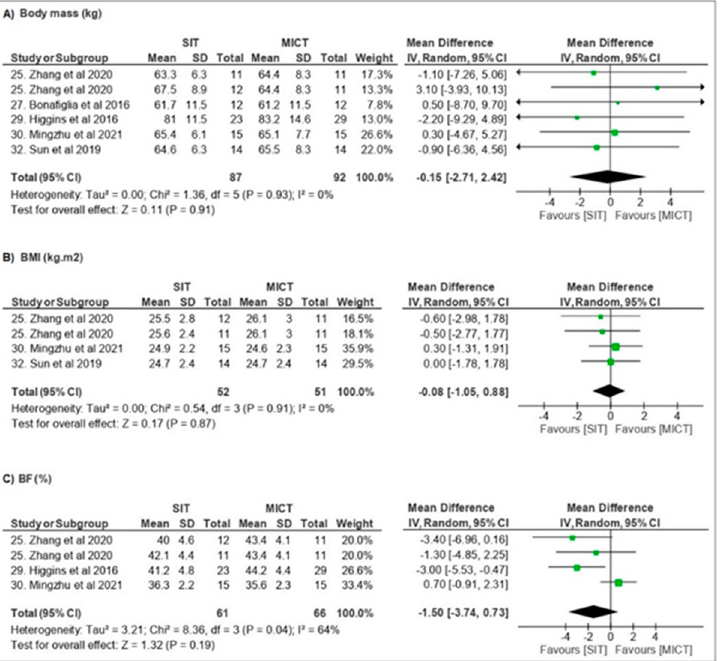
Figure 3. Forest plot of the effects of SIT vs. MICT intervention on outcomes: ( A ) body mass, ( B ) body mass index (BMI) and ( C ) percentage of body fat (BF%); SIT: supramaximal intervals; MICT: moderate intensity continuous training; IV—inverse of the variance; CI: confidence interval; SD: standard deviation.